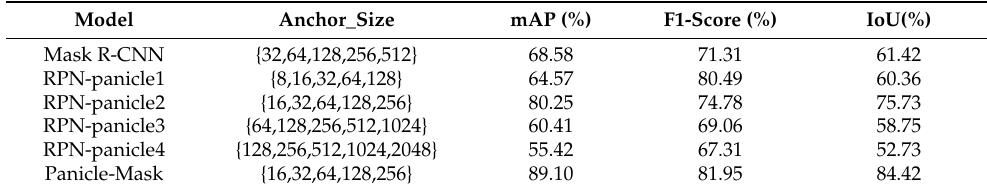
Table 1. Detection results of the models for different anchor box